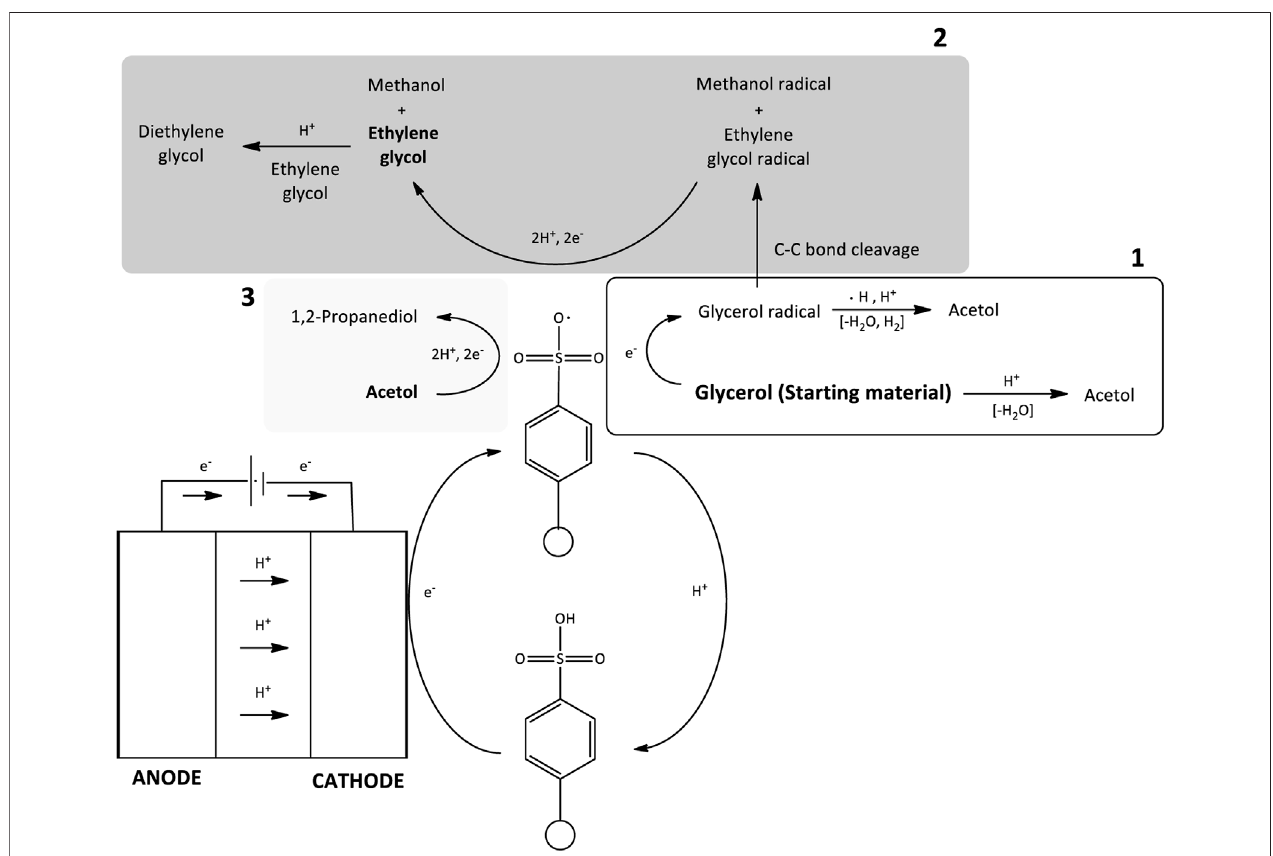
FIGURE 4 | Overall identi fi ed reaction mechanisms of glycerol electrocatalytic reduction reaction.